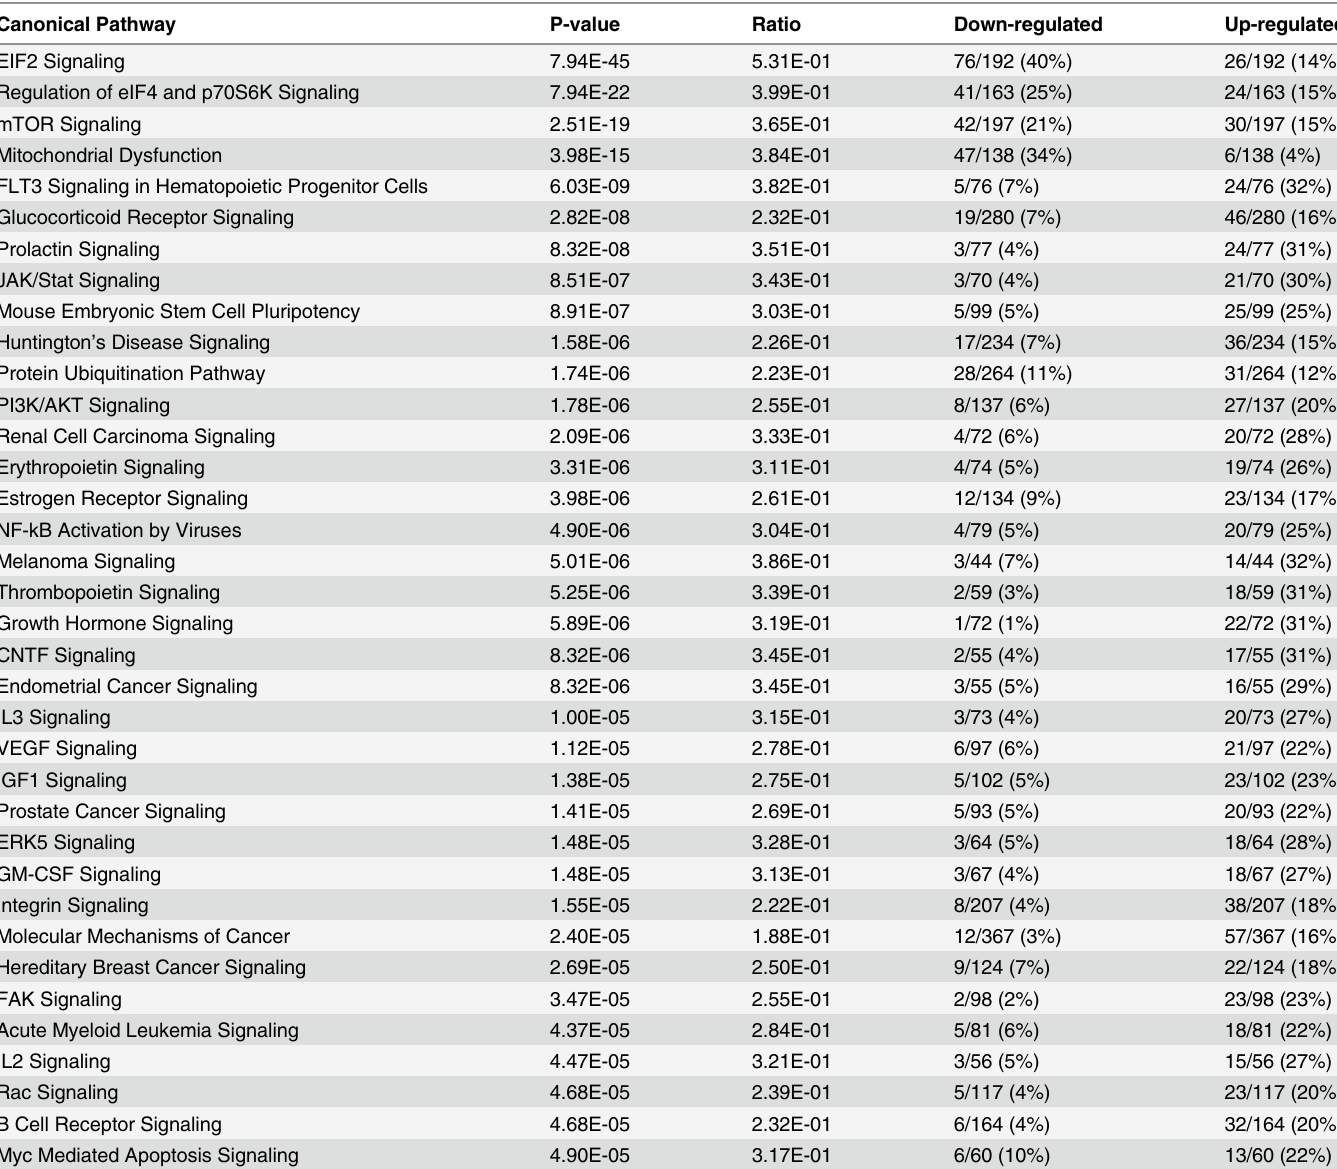
Table 3. The canonical pathways most significantly enriched by differentially expressed genes in response to vaccination prior to calving. Canonical